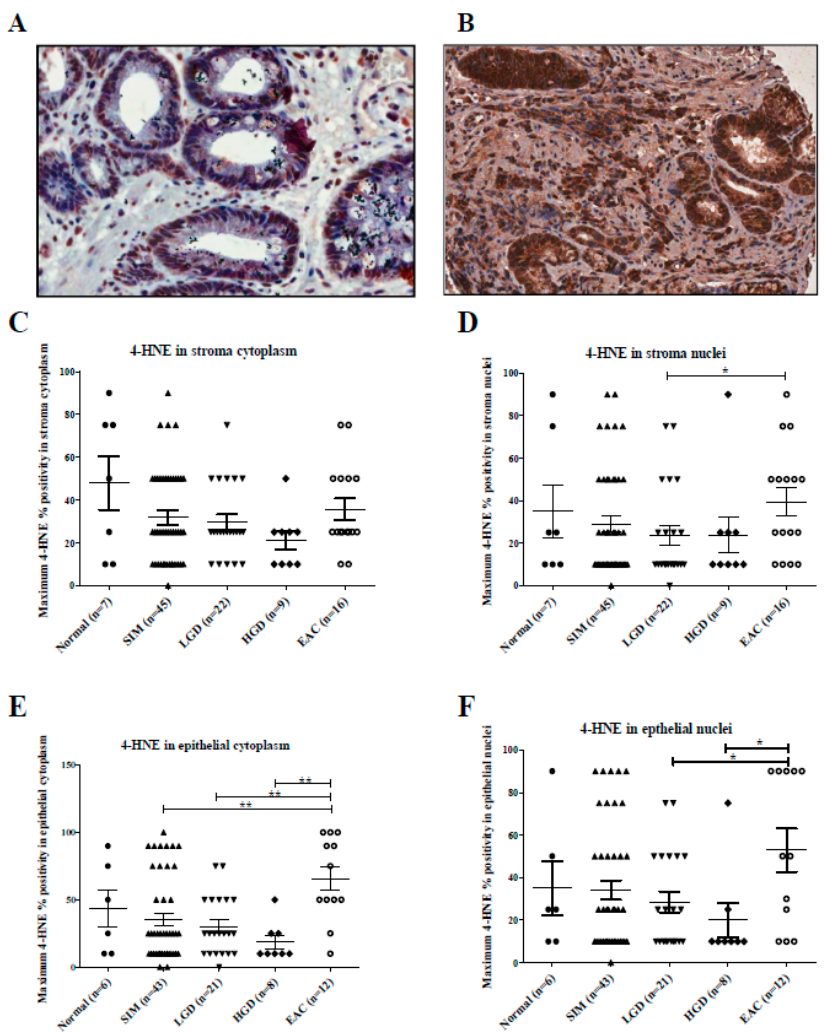
Figure 2. ( A – F ): 4-HNE stroma and epithelial staining in aged-matched histology groups across the Barrett’s esophagus disease spectrum. ( A ) Section of a core of Barrett’s intestinal metaplasia, at magnification 40 × , showing approximately 50% epithelial cytoplasmic staining of weak intensity for 4-HNE and approximately 25% moderate to strong epithelial nuclear staining. ( B ) Section of a core of invasive EAC, at magnification 40 × , demonstrating strong epithelial cytoplasmic staining in 100% of cells and strong staining in the stroma cytoplasm. ( C ) Kruskal–Wallis analysis with Dunn’s multiple comparison test demonstrated no significant di ff erence in the levels of 4-HNE in the stroma cytoplasm ( p = 0.309). ( D ) There was a significant di ff erence in the levels of 4-HNE in stroma nuclei between low-grade dysplasia (LGD) and EAC. There were significant di ff erences in 4-HNE levels in ( E ) the cytoplasm and ( F ) nuclei between esophageal adenocarcinoma and earlier stages of the Barrett’s disease spectrum. * p < 0.05, ** p <